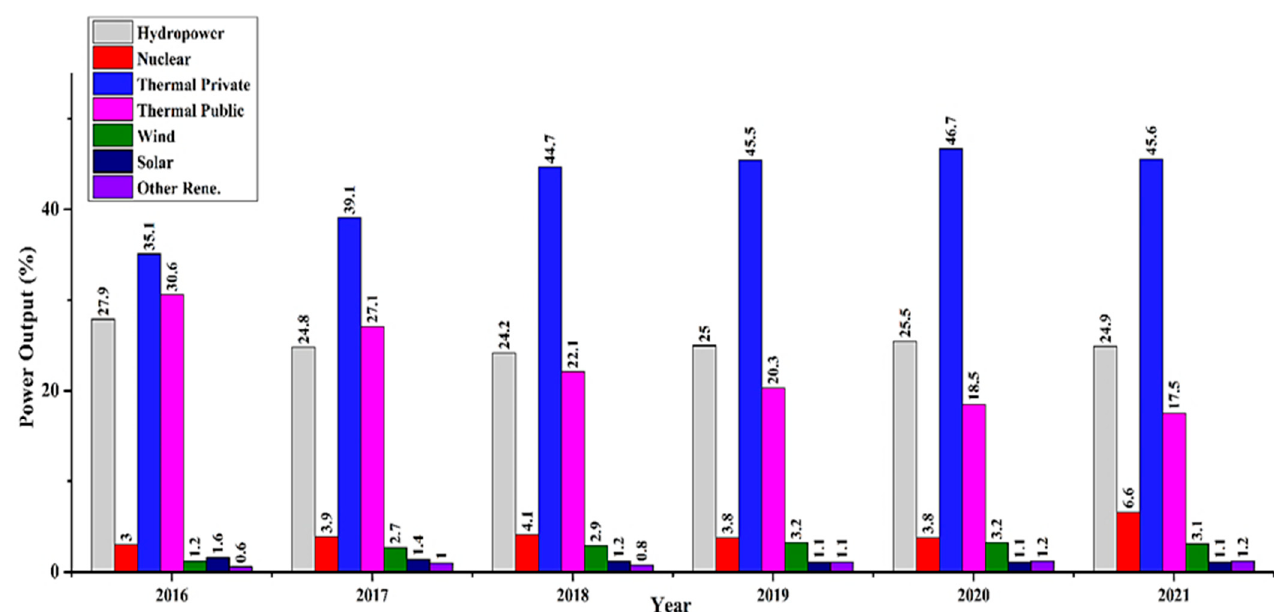
Figure 5. Installed Generation Capacity of Pakistan. Figure 5 . Installed Generation Capacity of Pakistan. Figure 5 . Installed Generation Capacity of Pakistan.